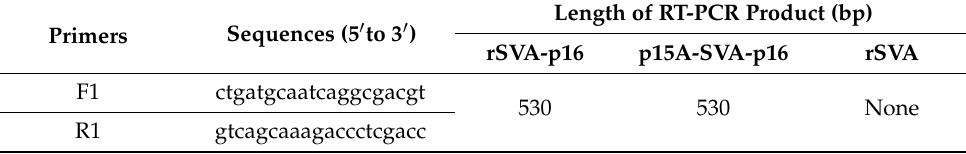
Table 1. The primers of